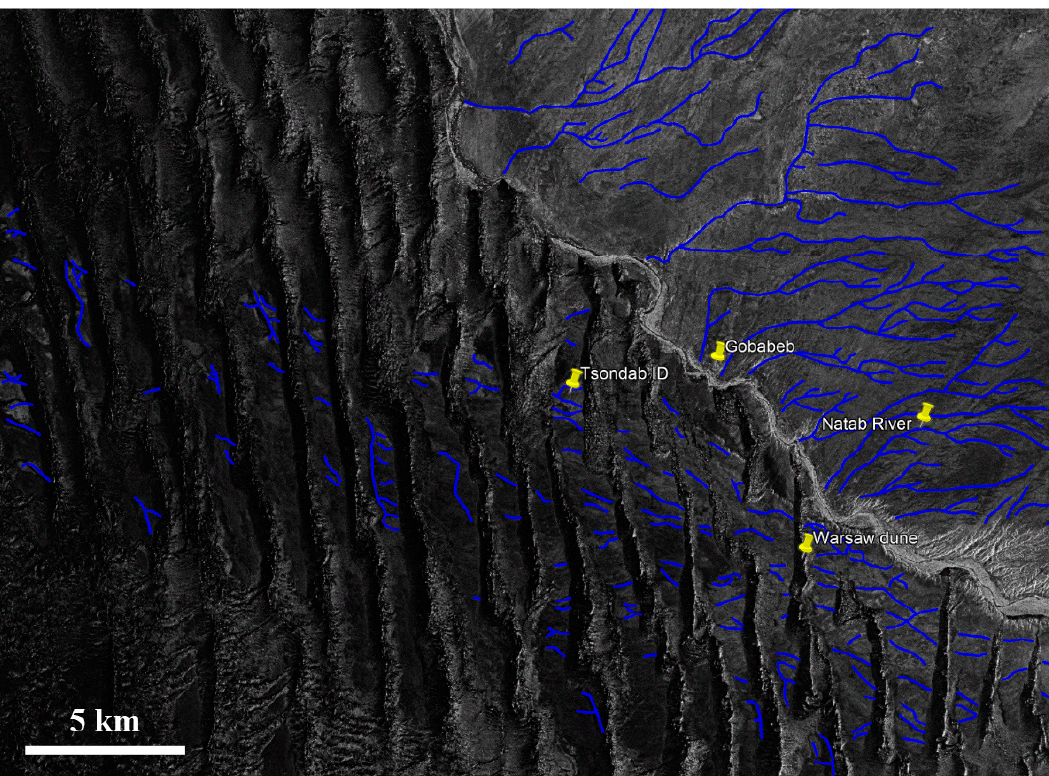
Figure 3. ( Top ): Landsat image of the Kuiseb River area with radar-detected channels indicated in blue. ( Bottom ): Corresponding PALSAR-2 radar image.